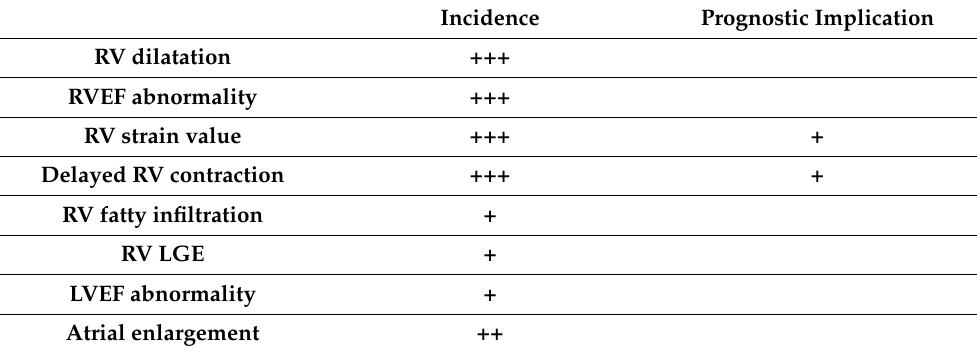
Table 2. Incidence of imaging abnormalities in BrS patients on the basis of the number of studies which detected the abnormality and data available about prognostic implications till now. Incidence Prognostic Implication RV